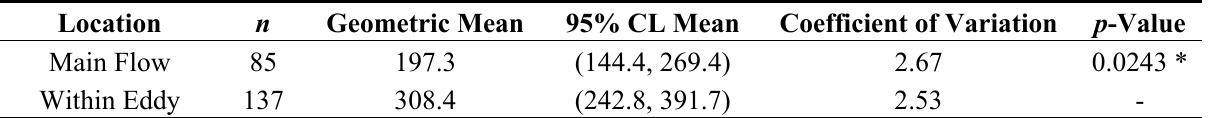
Table 2. E. coli concentrations within the eddy versus in the main flow of the river for the Santiago & Cayapas Rivers.